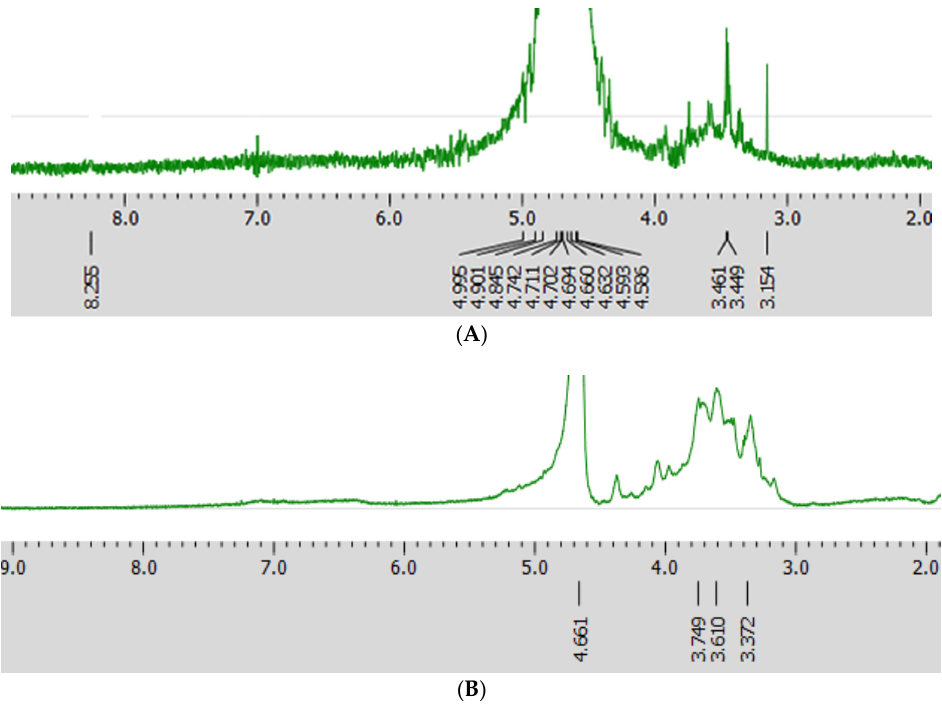
Figure 4. 1 H ‐ NMR spectrum ( A ) HIOP1 ‐ S; ( B ) HIOP2 ‐ S. Figure 4. 1 H-NMR spectrum ( A ) HIOP1-S; ( B ) HIOP2-S.